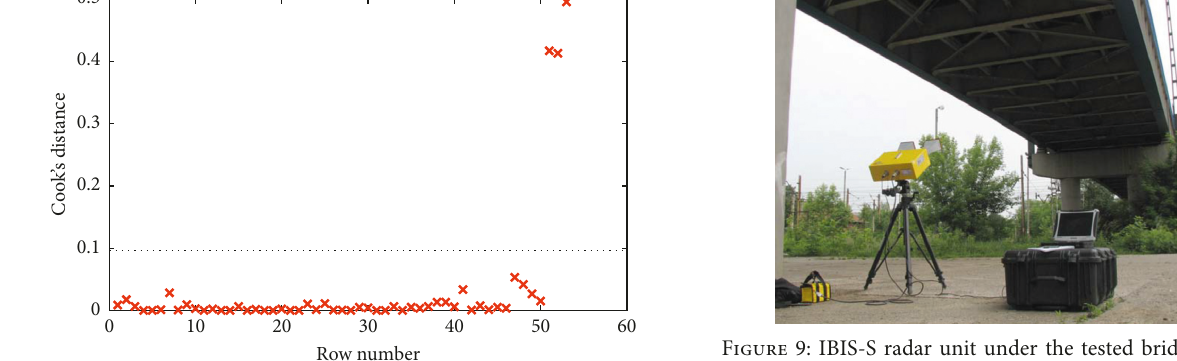
Figure 8: Cook’s distance calculated for the linear model of DSF coefficients [24] (reproduced from [24], under the Creative Com- mons Attribution-NonCommercial 4.0 International License).